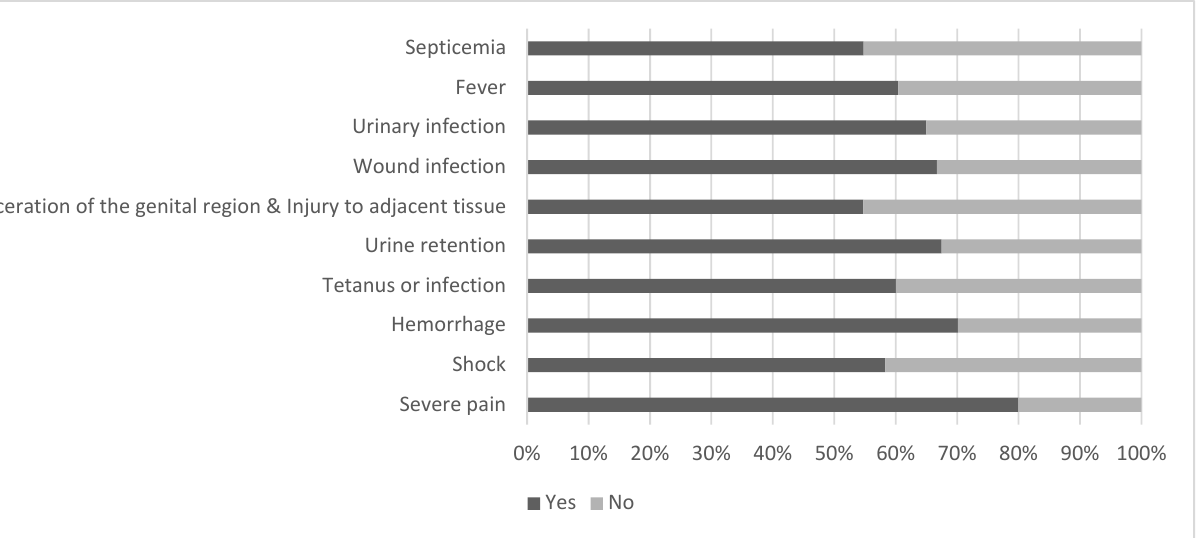
Figure 1. Participants’ knowledge about possible immediate complications caused by FGM in percetages ( n =